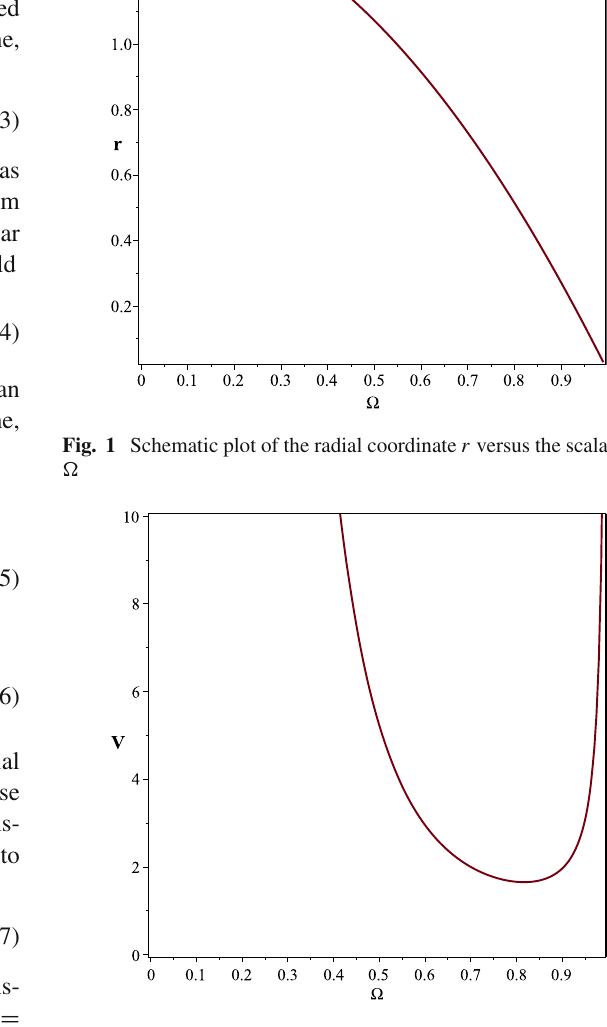
Fig. 2 Schematic plot of the scalar field (cid:16) versus the potential